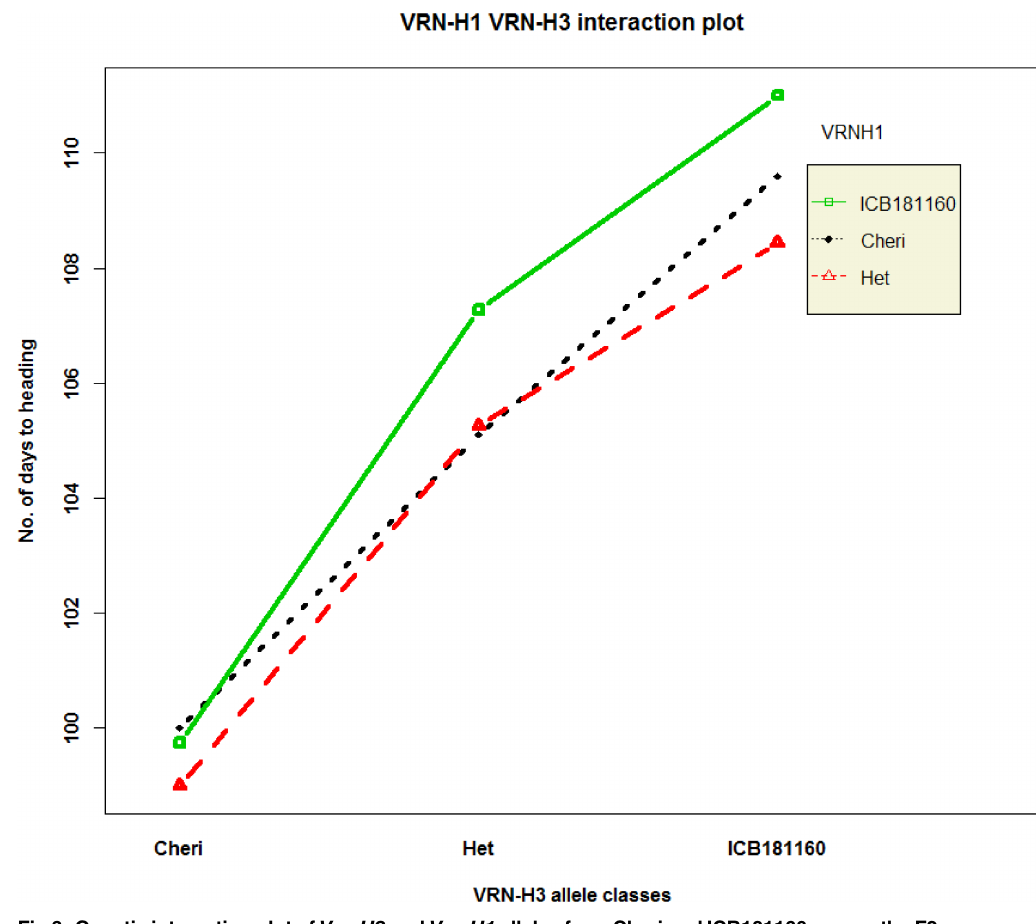
Fig 3. Genetic interaction plot of Vrn-H3 and Vrn-H1 alleles from Cheri and ICB181160 among the F2 population for heading. All nine allele combinations of both genes are calculated using R-interaction